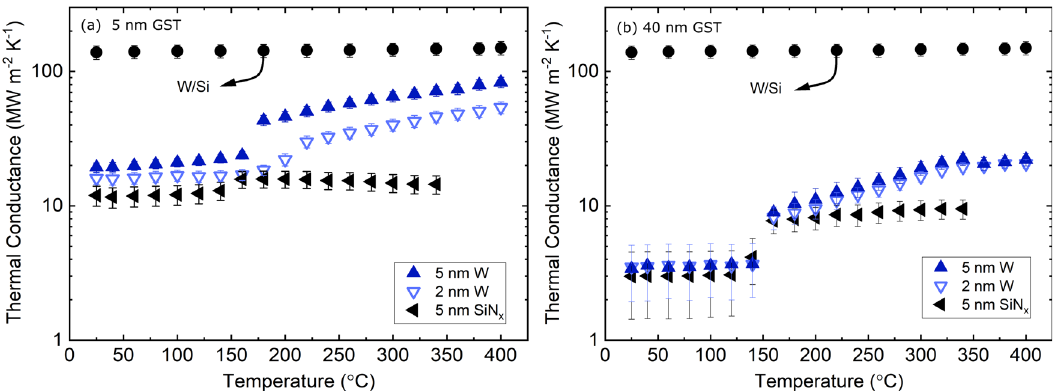
Fig. 4 Thermal conductance behavior of thin GST fi lms in the ballistic and diffusive regime. Thermal conductance for a 5- and b 40-nm-thick GST in contact with different spacers. The error bars are calculated based on 7% uncertainty in the GST fi lm thickness. Experimental data are not available for SiN x above 340 °C due to fi